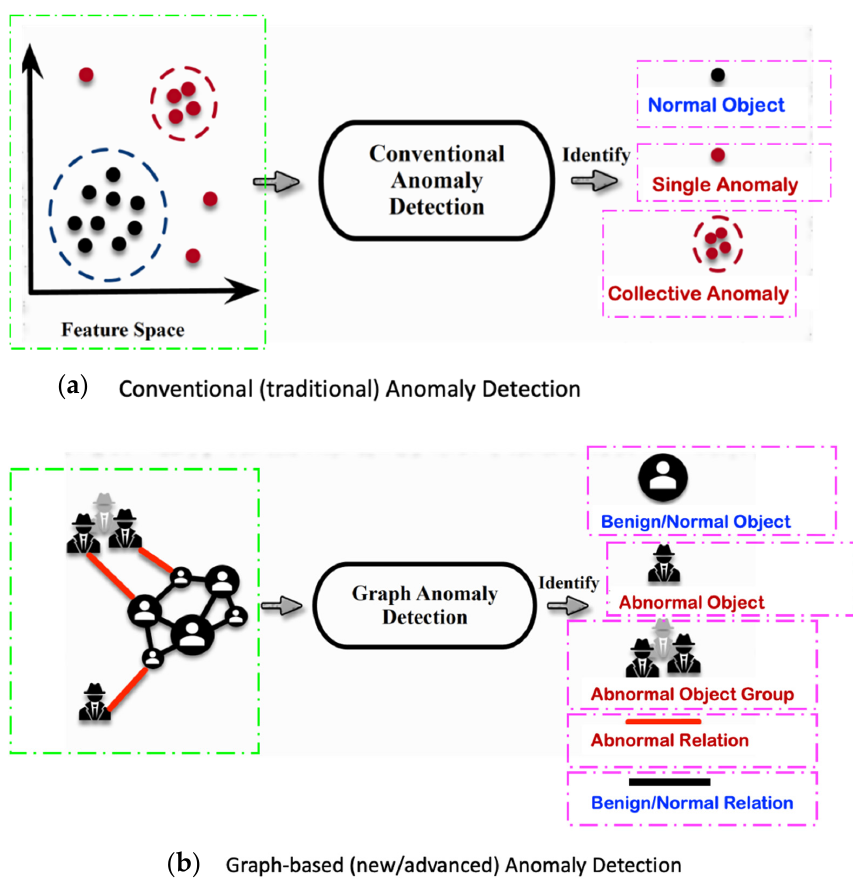
Figure 5. For illustration, Toy Examples—A comparison of “Conventional Anomaly Detection” (see part ( a )) and “Graph Anomaly Detection” (see part ( b )). Apart from anomalies shown in part ( b ) of the figure, graph anomaly detection also identifies graph-level anomalies.